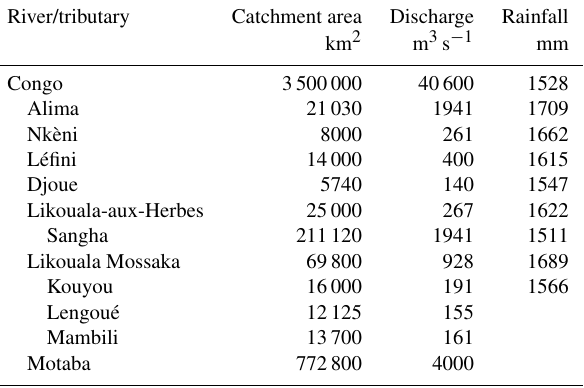
Table 1. Relevant physical characteristics of rivers studied in this work. All rainfall data are from Laraque et al. (2001), Djoue catch- ment area and discharge data are from Laraque et al. (1994) and all other data are from Laraque et al.